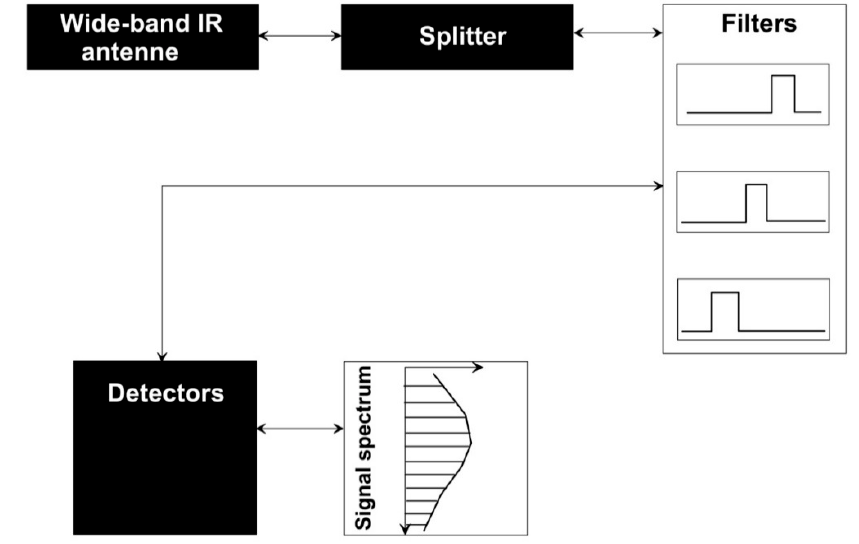
Figure 2. Block diagram of the sensor for measuring the spectrum of incoherent IR radiation.